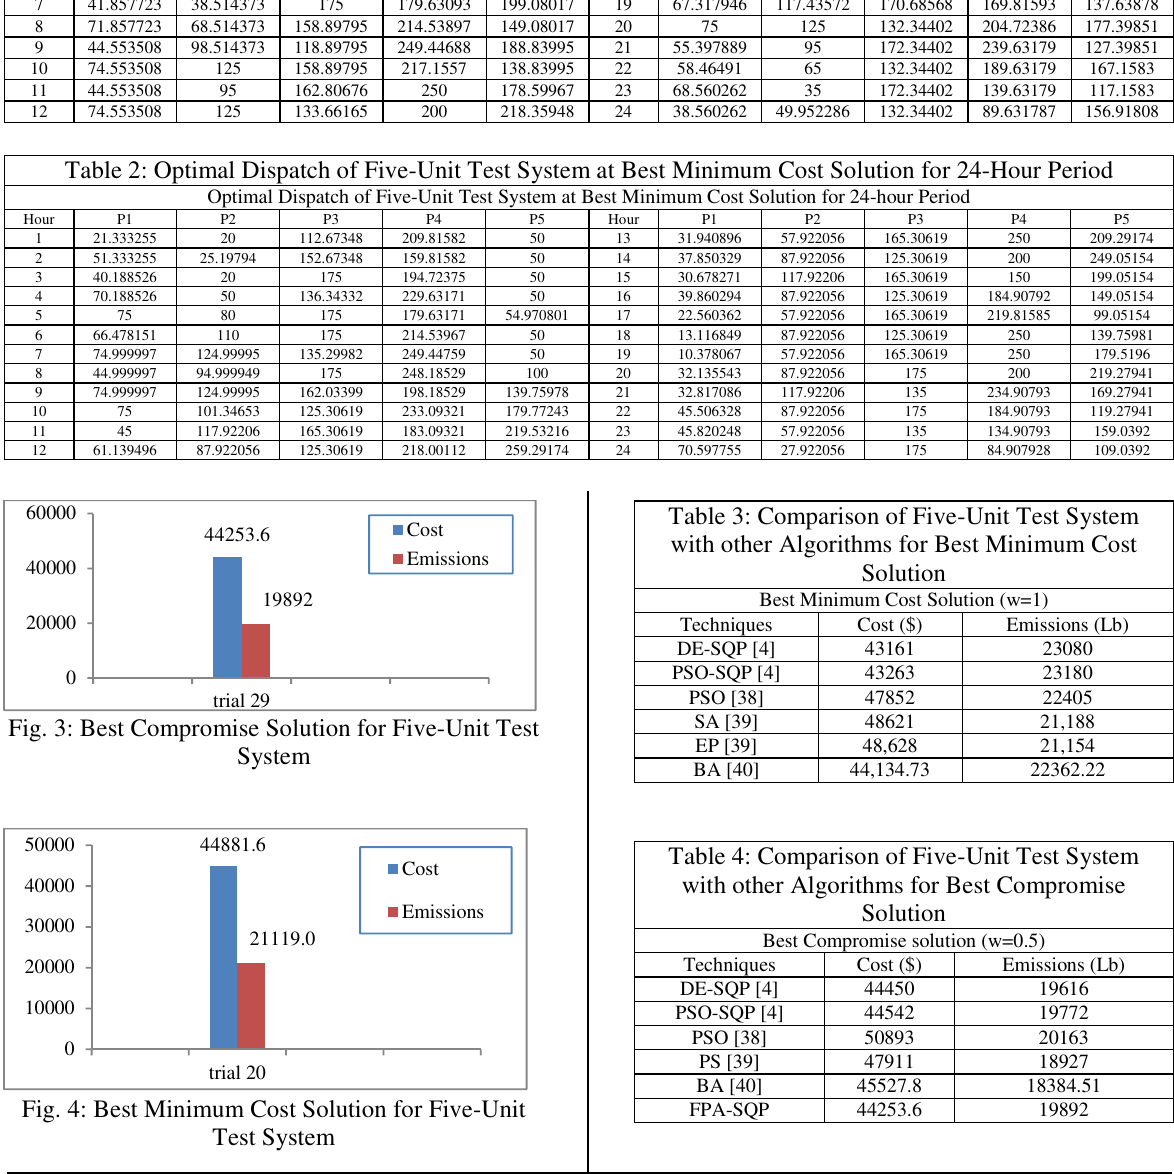
Fig. 4: Best Minimum Cost Solution for Five-Unit Test System